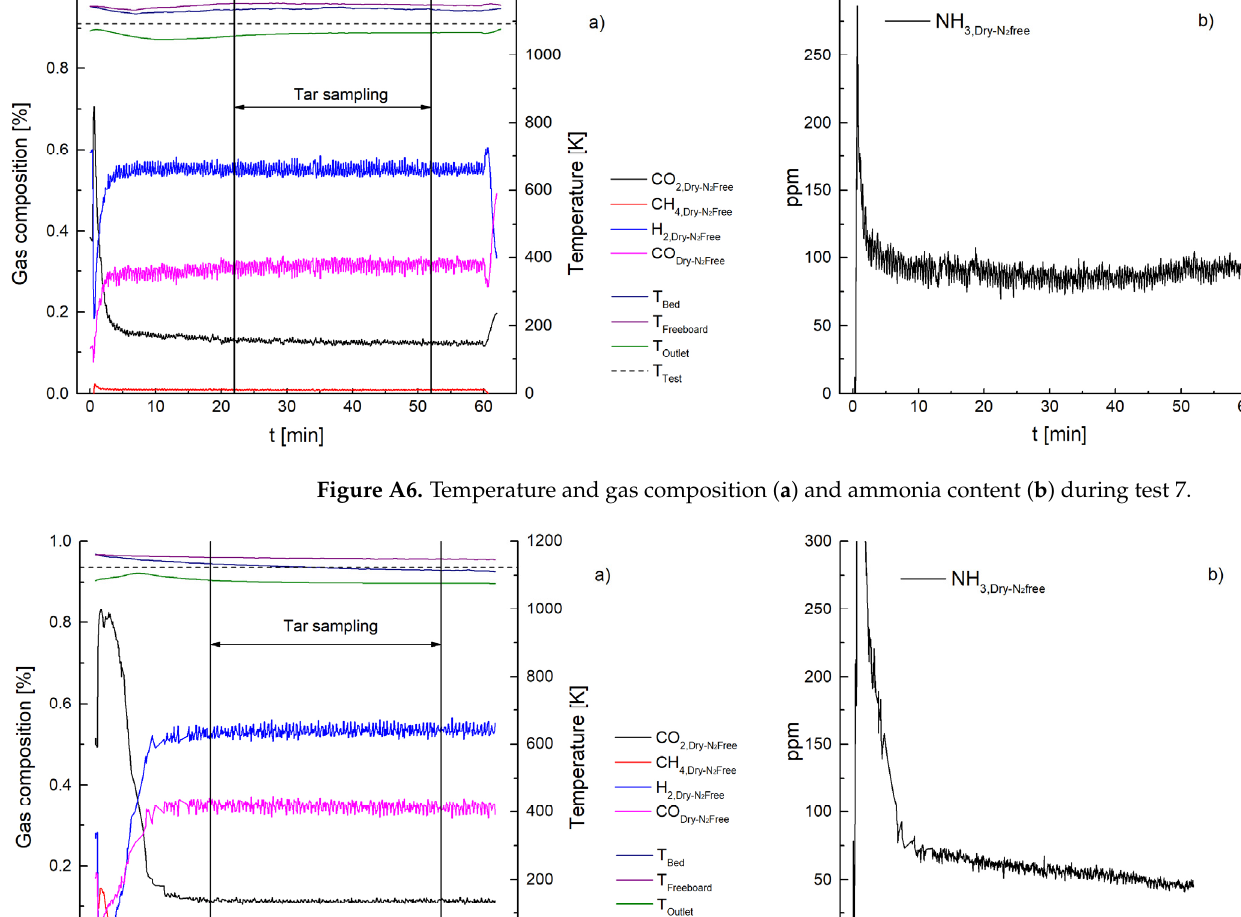
Energies 2023 , 16 , x FOR PEER REVIEW 12 of 15 Figure A4. Temperature and gas composition ( a ) and ammonia content ( b ) during test 4.